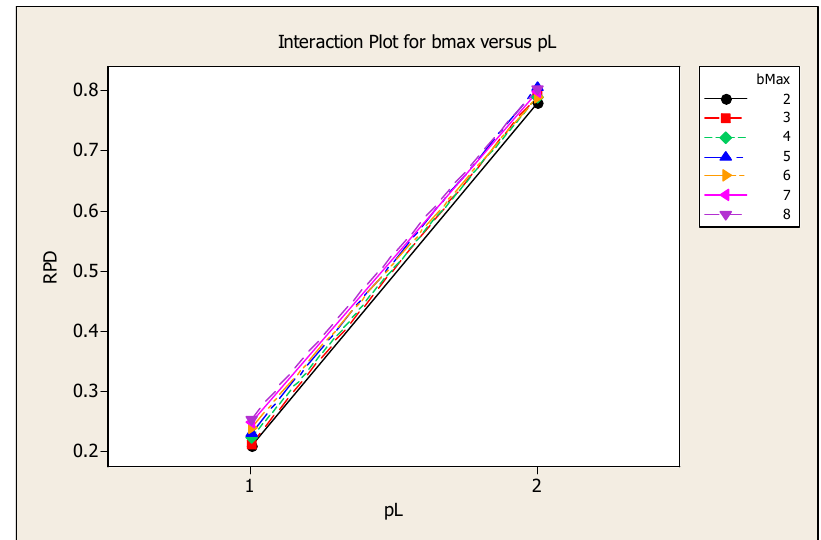
Figure 4. Interaction plot for bMax versus pL .